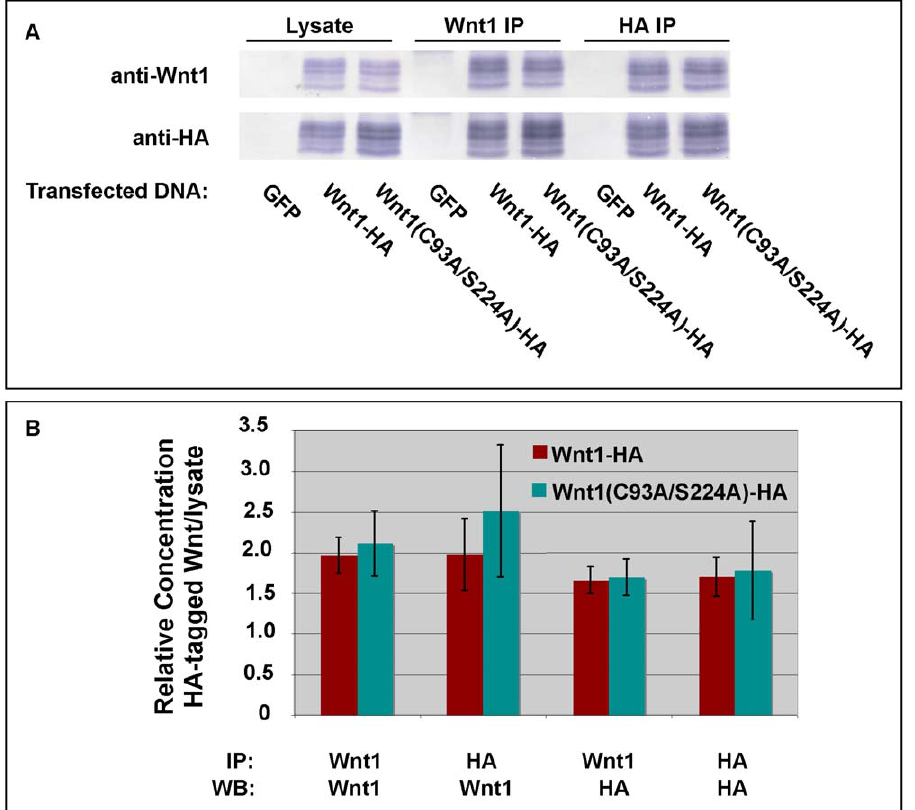
Figure 1. Wnt1 monoclonal antibody recognizes wild-type and lipid-deficient Wnt1 proteins. HEK293T cells were transiently transfected with constructs encoding either GFP (control), Wnt1-HA or Wnt1 C93A/S224A-HA. Cell lysates were immunoprecipitated with anti-HA or anti-Wnt1 (MAb 7B3-A10-F9), separated by SDS-PAGE and blotted onto PVDF. Western Blots were then probed with anti-HA or anti-Wnt1 (MAb 5F1-G11-D1) as indicated ( Panel A ). Blots were scanned and analyzed using NIH ImageJ. The quantitative results are shown in the graph in Panel B . This experiment was performed twice. Error bars indicate the standard error.